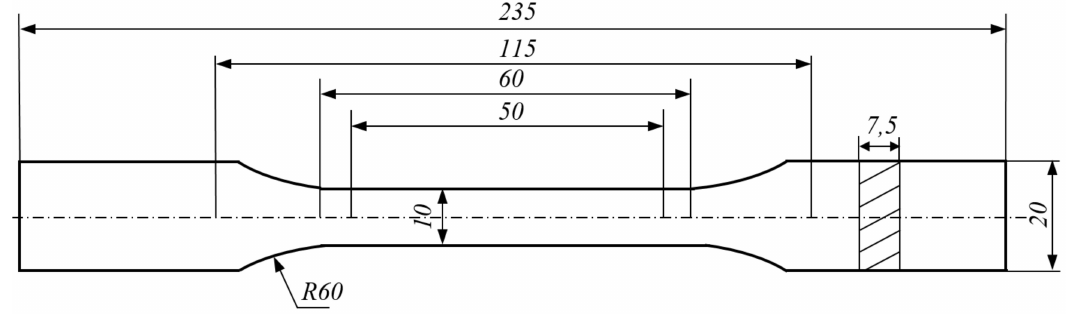
Figure 2. Dimensions of samples for static tensile test in accordance with PN-EN ISO 527-4_2000P.